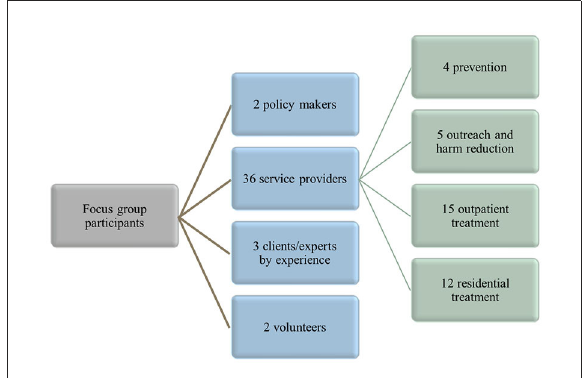
FIGURE2 Participants of the four focus groups in Belgium ( n =